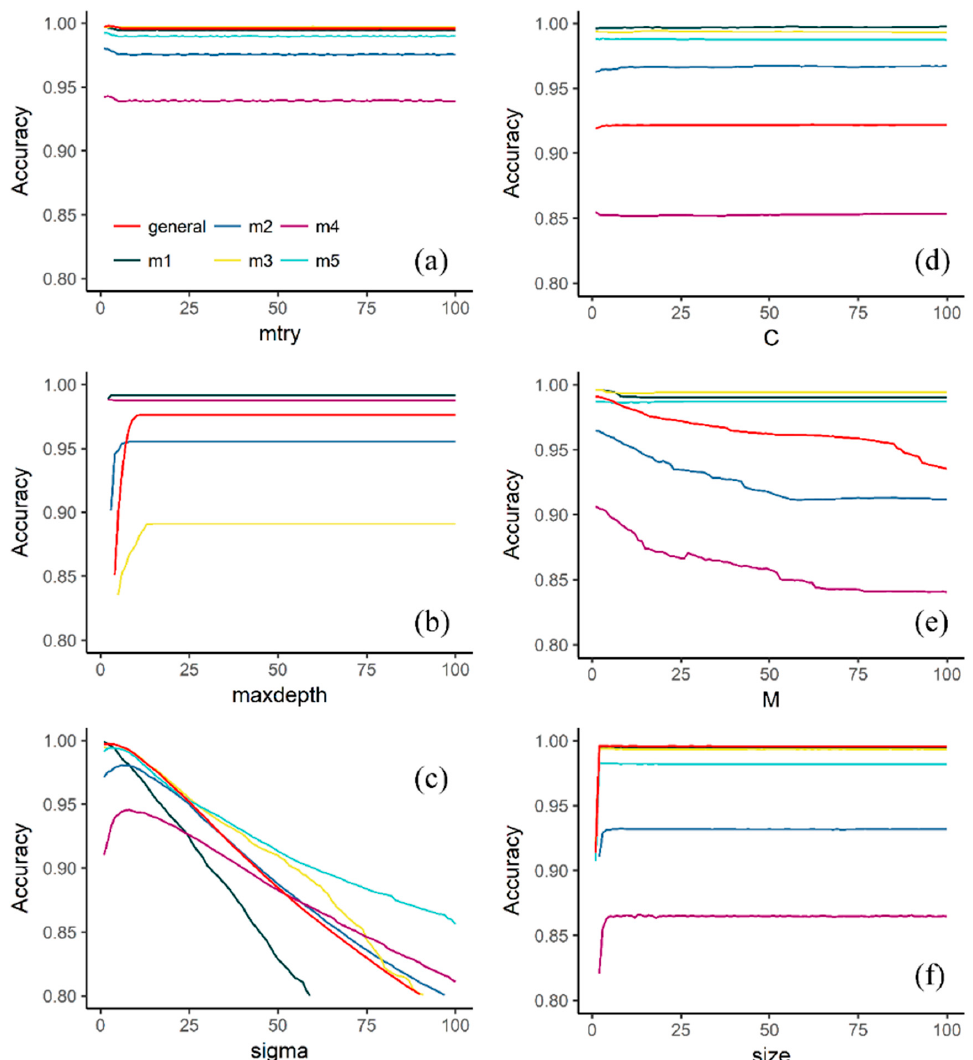
Figure 3. The accuracy of the validation samples of six machine learning algorithms using the Bootstrap 632 method. ( a ) Random forest, ( b ) conditional inference tree, ( c ) support vector machines with radial kernel, ( d ) support vector machines with linear kernel, ( e ) C4.5-like trees, ( f ) neural network.